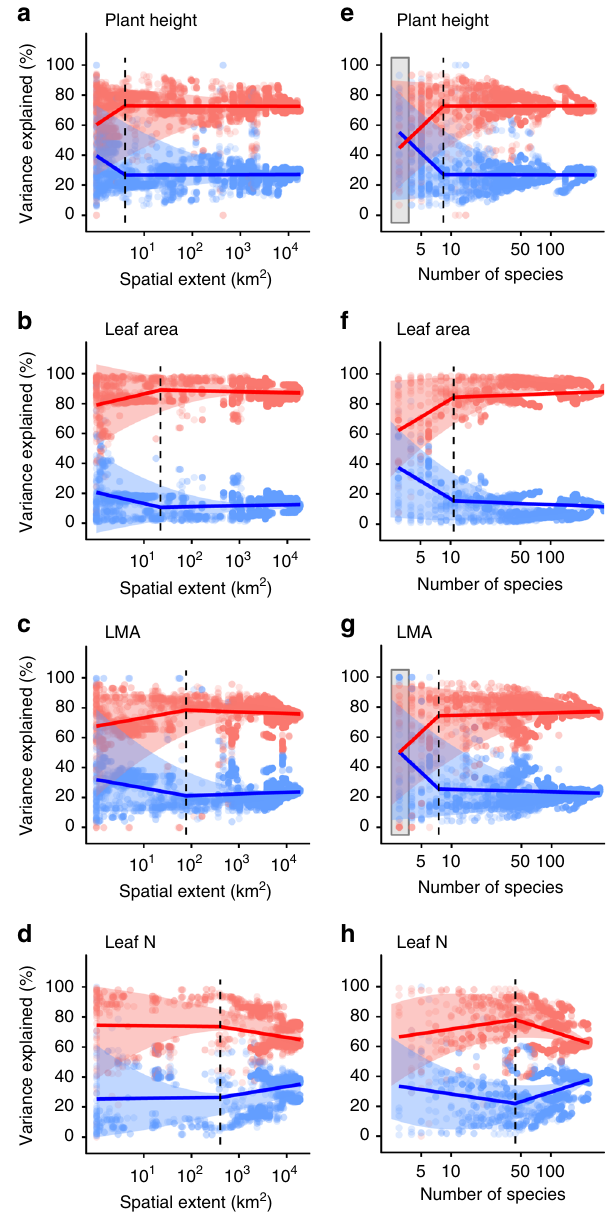
Fig. 4 Sources of trait variation across geographic scales. Among-species trait variation (red) accounts for the majority of total trait variation across the tundra, but the importance of within-species trait variation (blue) increases at local scales and at low species richness in most traits. Sources of trait variation across geographical scale ( a – d ) and species richness ( e – h ) for plant height, leaf area, LMA and leaf nitrogen (see also Supplementary Figs. 5 – 7). Coloured lines indicate linear break point model fi ts with one break point (dashed line). Grey boxes indicate where differences between among-species and within-species variation are not signi fi cant ( P >